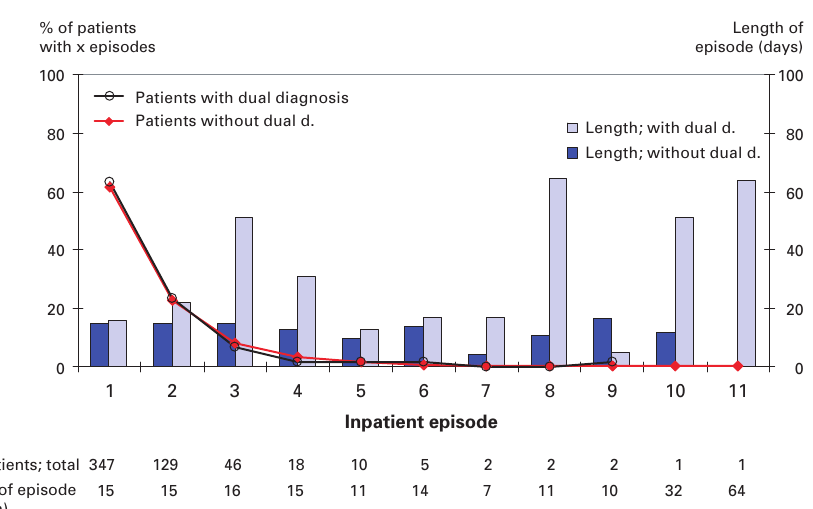
Figure 1 Number and length of inpatient psychi- atric episodes over the 5-year period after first admission in patients admitted for SUD with and without dual diagno-